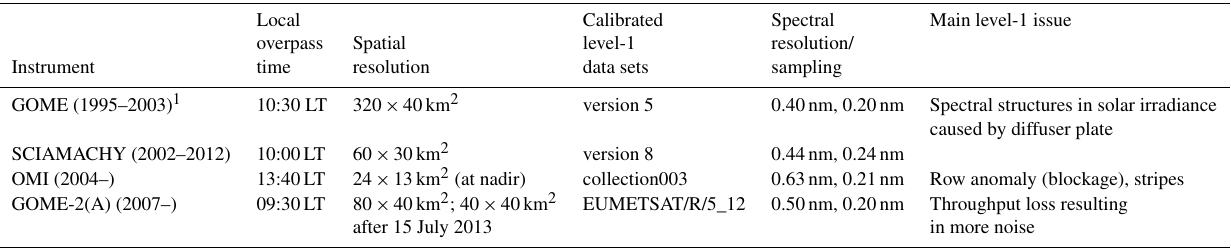
Table 2. Satellite instruments and level-1 data contributing to the QA4ECV NO 2 ECV data